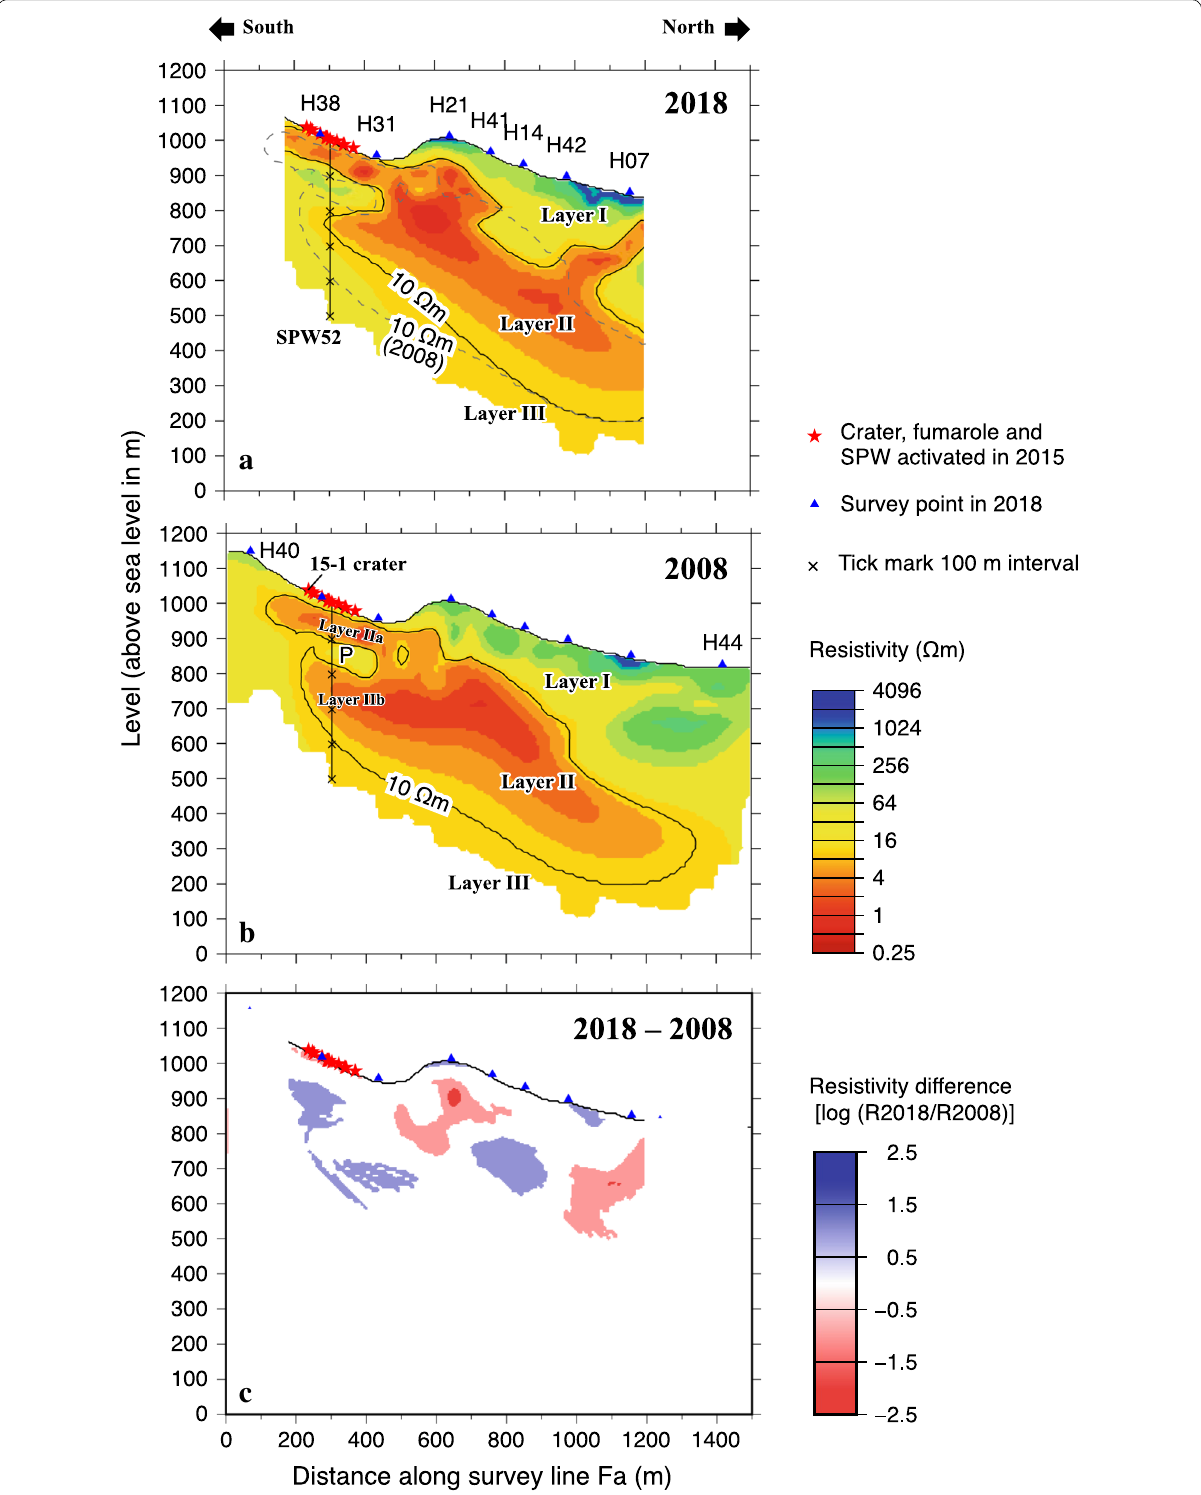
Fig. 5 Cross-sectional resistivity structure along survey line Fa: a 2018 survey, b 2008 survey, and c resistivity change in log (R2018–R2008). P indicates the resistive portion within Layer II, which is considered a vapor pocket. U indicates a possible upwelling of hot springs from Layer II. See text for a more detailed interpretation of P and